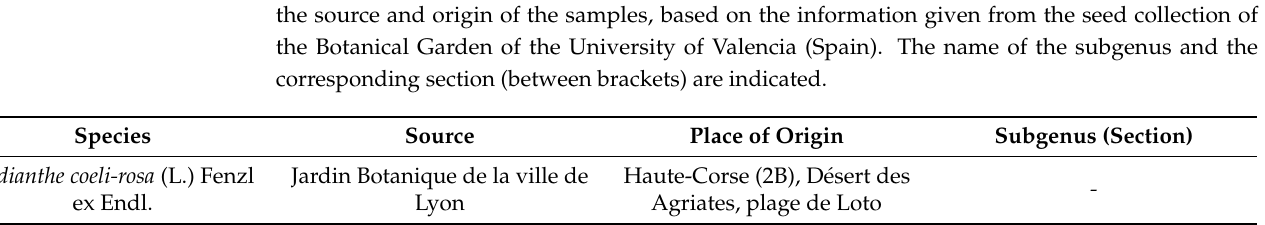
Figure A5. Average silhouettes for the lateral and dorsal views of species in the papillose group.